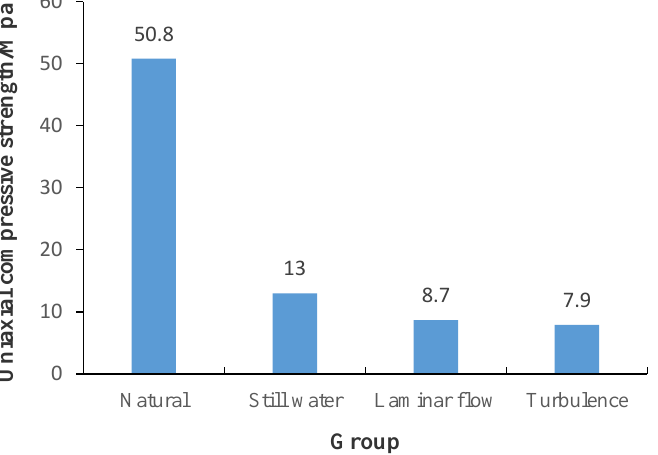
Figure 10. Comparison of the value of the uniaxial compressive strength of red sandstone under different flow patterns.